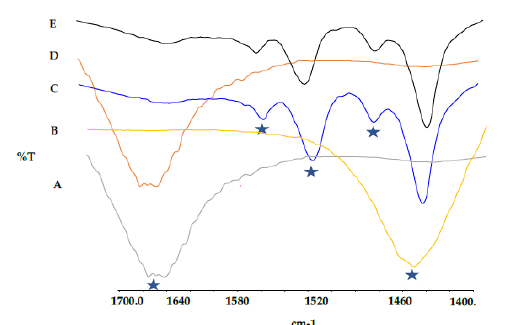
Figure3. Pyridine-FT-IRof( A )MgGa-NaY,( B )SrGa-NaY,( C )Ga-NaY,( D )CaGa-NaYand( E )BaGa-NaY Figure 3. Pyridine-FT-IR of ( A ) MgGa-NaY, ( B ) SrGa-NaY, ( C ) Ga-NaY, ( D ) CaGa-NaY and ( E ) BaGa- Catalysts 2020 , 10 , x FOR PEER REVIEW carried out at T = 100 ◦ C. NaY carried out at T = 100 o C.